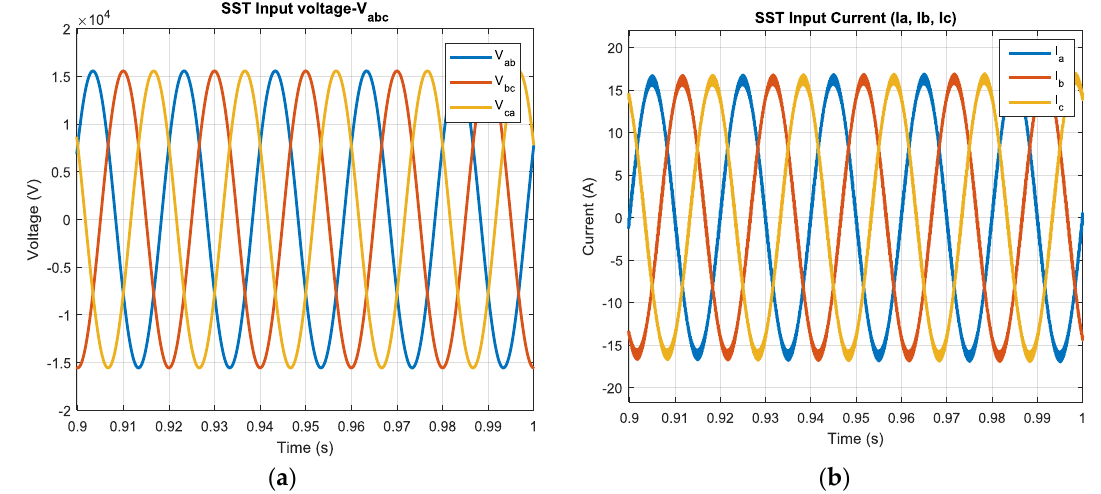
Figure 8. ( a ) SST input voltage at the grid side. ( b ) SST input current at the grid side.